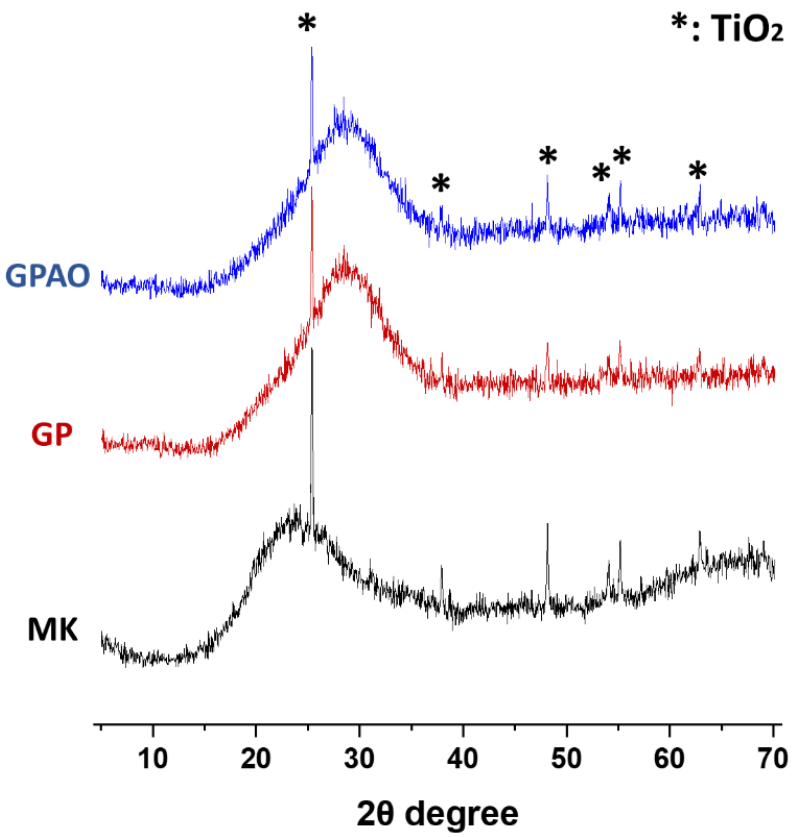
Figure 5. XRD diffraction patterns of the used MK and the prepared GP and GPAO aged 56 days.